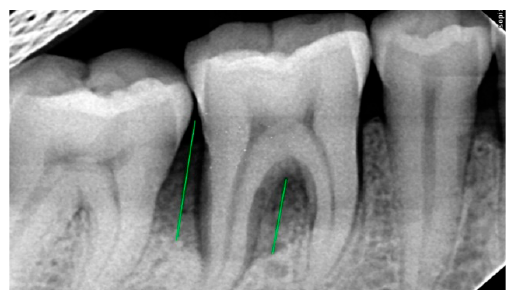
Figure 3. Pre-Operative X-Ray of 46 showing bone defect.